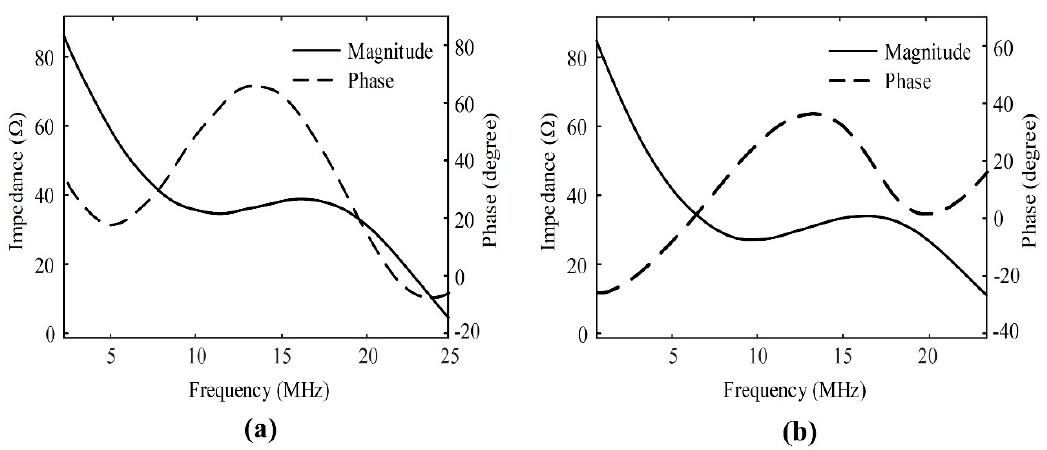
Figure 12. The measured electrical impedance magnitude and phase of (a) the single focal point transducer and (b) a seven-focal-point transducer.